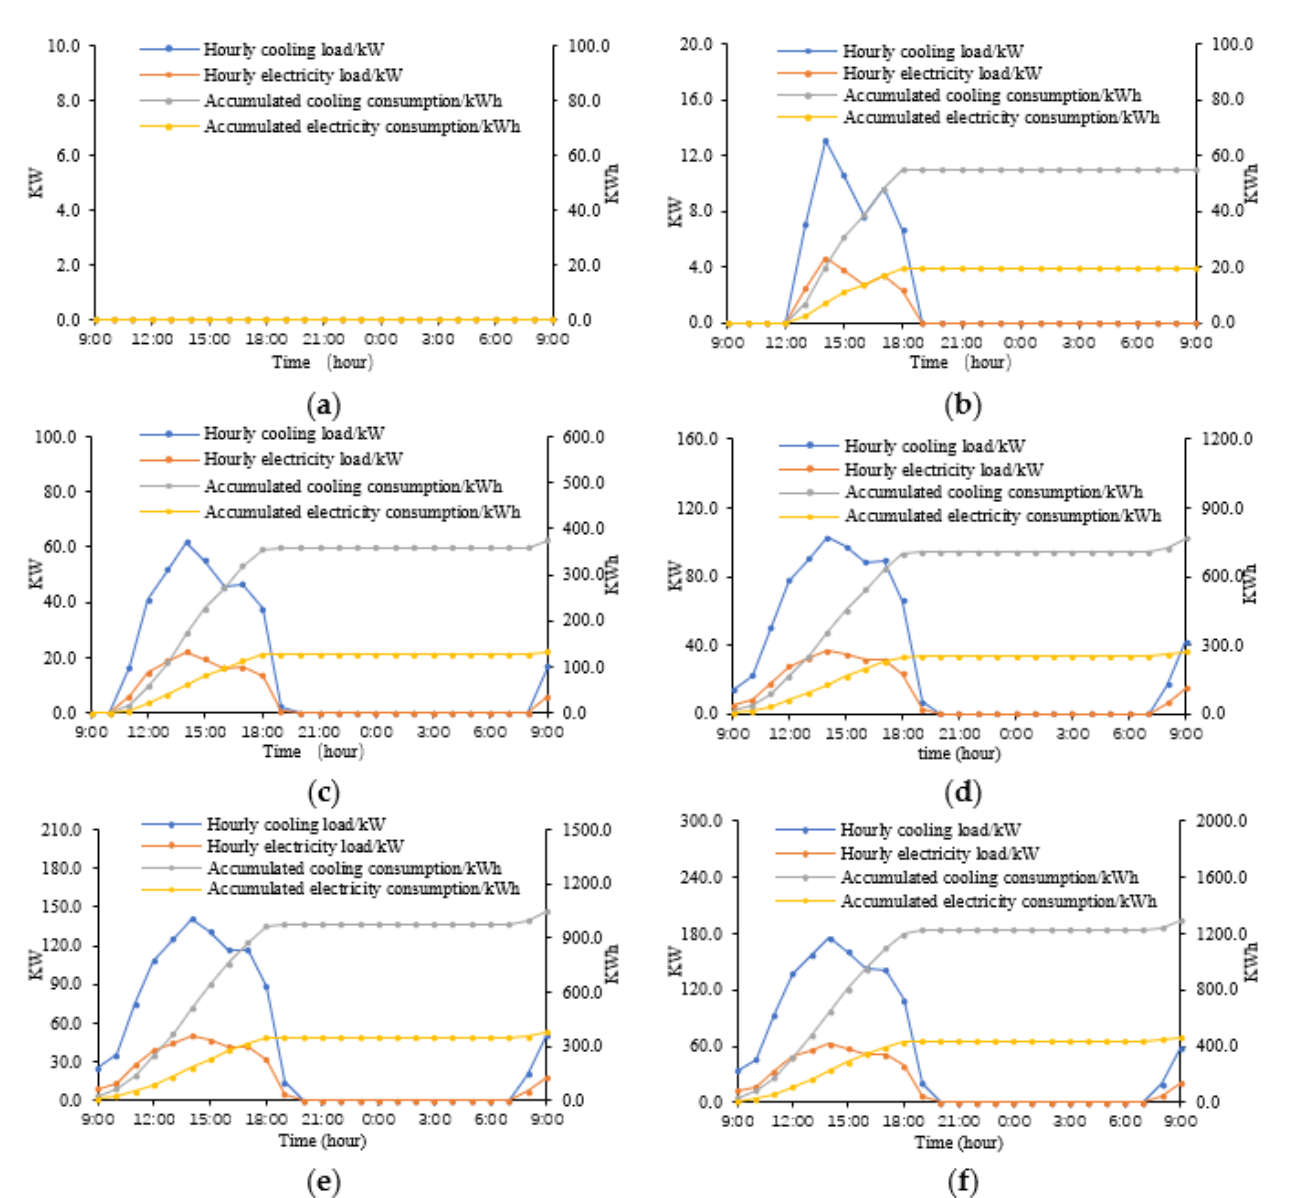
Figure 12. The cooling energy demands of the six scenarios: ( a ) Energy demand of 0% WWR building; ( b ) Energy demand of 20% WWR building; ( c ) Energy demand of 40% WWR building; ( d ) Energy demand of 60% WWR building; ( e ) Energy demand of 80% WWR building; ( f ) Energy demand of 100% WWR building.